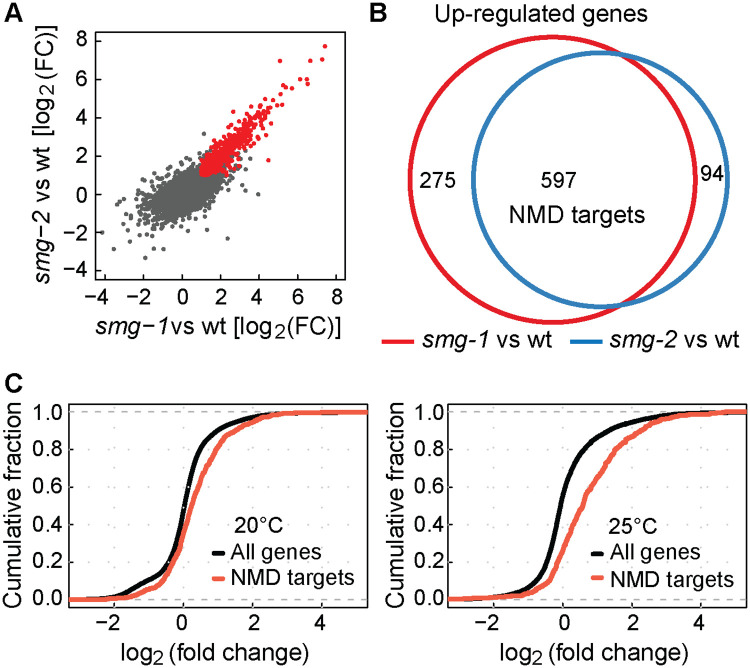
Genome-wide up-regulation of NMD mRNA targets in the absence of CLK-2.(A) Examination of changes in transcript levels, relative to wild type, between smg-1(rrr59) and smg-2(rrr60) mutants; correlation coefficient (r) of 0.838 indicates a strong correlation. In red are transcripts up-regulated at least two fold in both mutants (log2FC > 1, p-value < 0.05). “FC” = fold change. (B) Venn diagram highlighting the overlap between transcripts up-regulated in smg-1(rrr59) or smg-2(rrr60) mutants. The “NMD targets” are transcripts up-regulated in both mutants. (C) Cumulative distribution function (CDF) plots illustrating changes in the abundance of NMD targets (defined in B) in clk-2(qm37) mutants. Left: The animals were grown at 20°C (permissive temperature for clk-2(qm37)); note a modest up-regulation of NMD targets (Kolmogorov-Smirnov test, p-value < 0.0001). Right: The animals were grown at 25°C (restrictive temp.); note a stronger up-regulation of NMD targets (Kolmogorov-Smirnov test, p-value < 0.0001).